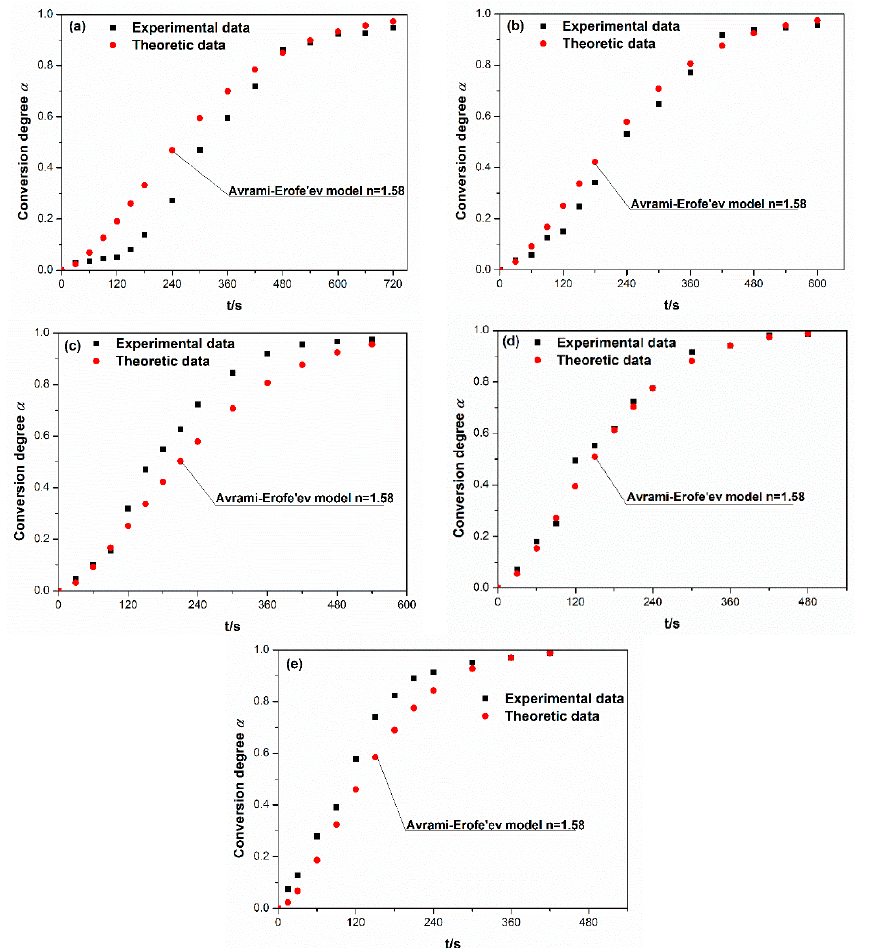
Figure 8. Comparison of the experimental data with the Avrami–Erofe’ev topochemical kinetic model ( n = 1.58) applied in this study: ( a ) 500 °C; ( b ) 525 °C; ( c ) 550 °C; ( d ) 575 °C; ( e ) 600 °C. ( n = 1.58) applied in this study: ( a ) 500 ◦ C; ( b ) 525 ◦ C; ( c ) 550 ◦ C; ( d ) 575 ◦ C; ( e ) 600 ◦